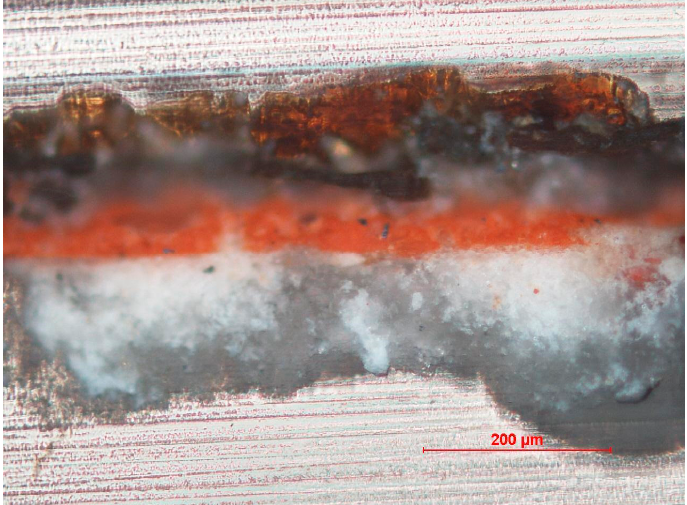
Figure 13. Sample from the remaining mecca gilding of the chandeliers in the upper register. The microscopic image shows four layers: a first layer of translucent brown lacquer or organic resin, a grey metal layer, a red layer (pictorial layer) and finally, the white forth stratum is the preparation layer.